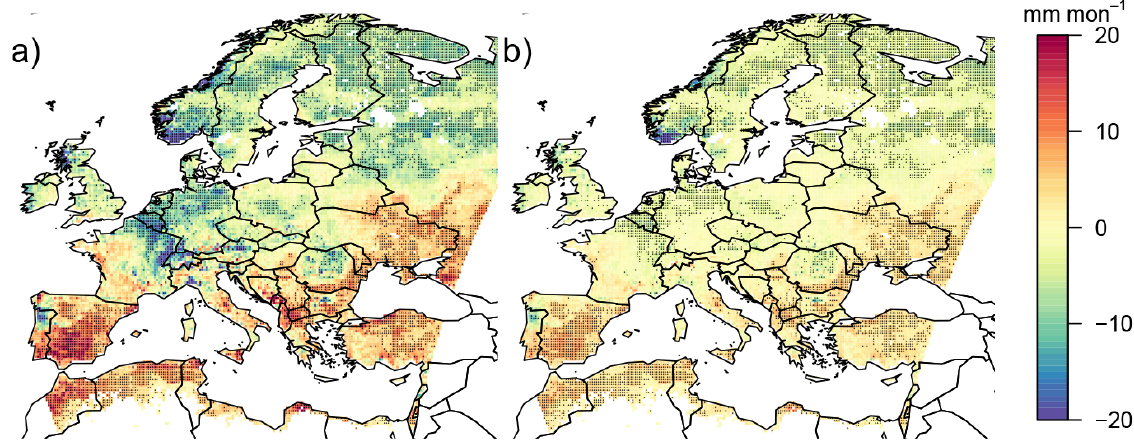
Figure A1. Ecosystem vulnerability (a) and risk (b) of carbon losses (negative NBP) to P for the period 1981 to 2010. Reddish colours indicate high vulnerability to water shortage; significant cells are marked with black dots.